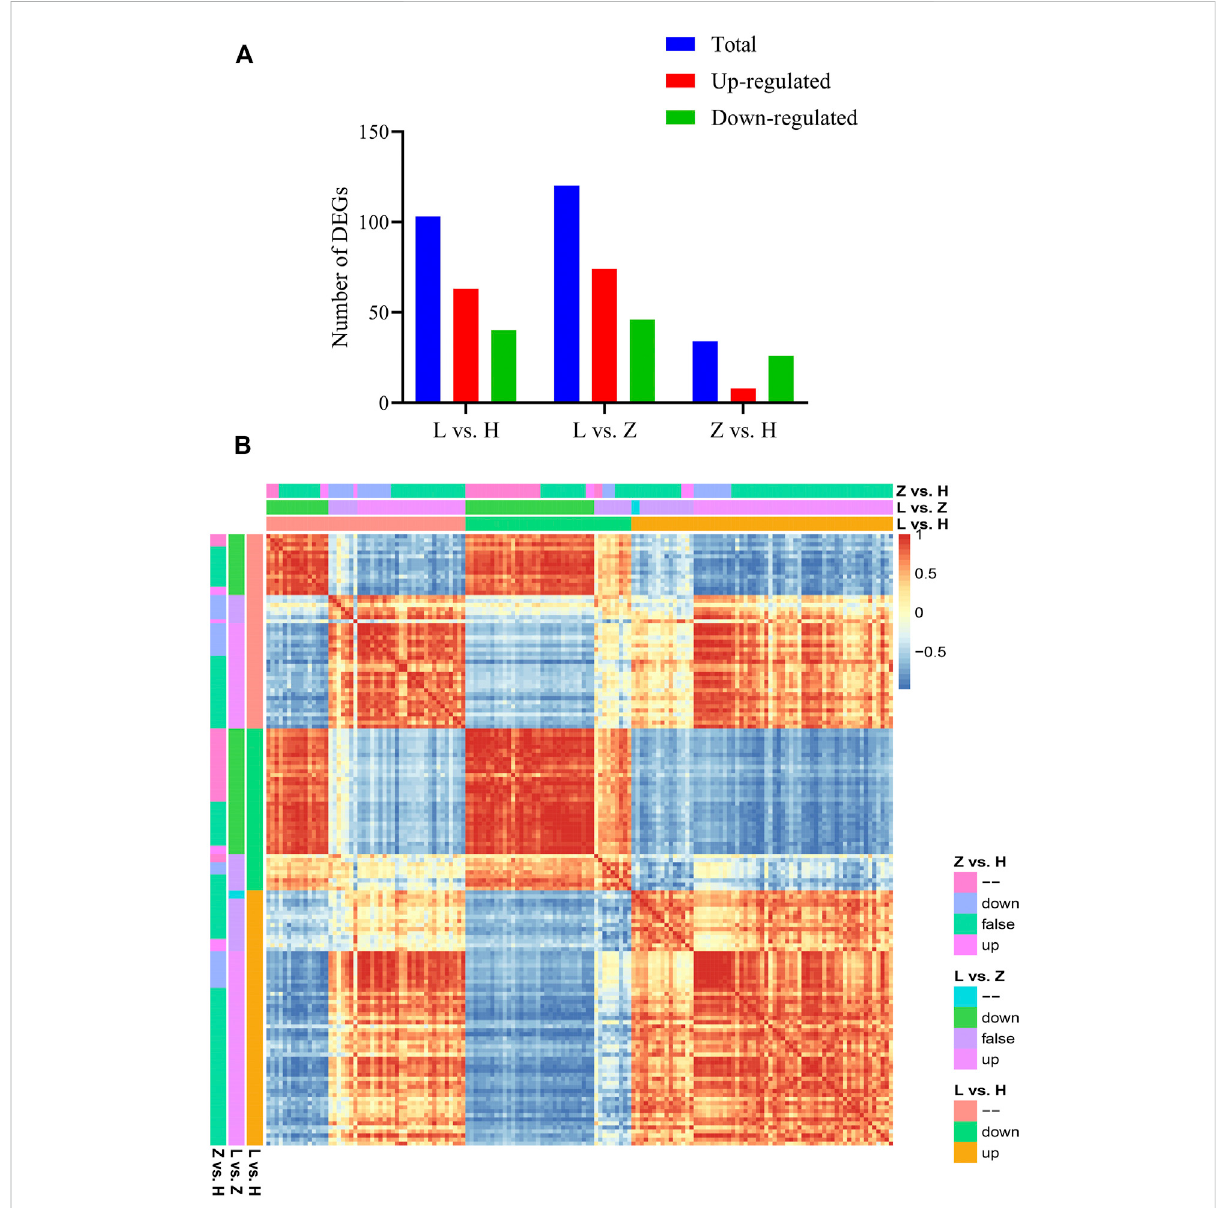
FIGURE 6 Characterization of color-related DEGs identi fi ed based on the annotation information. (A) statistics for color-related DEGs in three comparisons between green, yellow, and purple leaves, viz ., L vs. H, L vs. Z, and Z vs. H. (B) correlation plot representing PCC between color-related DEGs (151), where down = downregulated, up = upregulated, false = log 2 Fold Change is between − 1 and